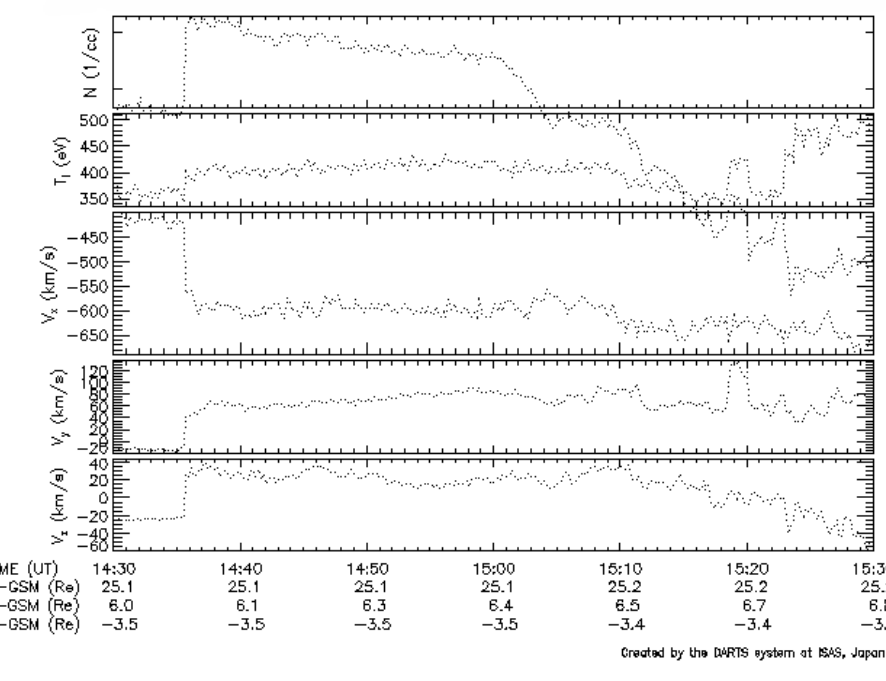
Fig. 13. Solar wind parameters measured by the Geotail satellite on 15 July 2000. From the top to bottom; density; temperature; x , y , and z -components of